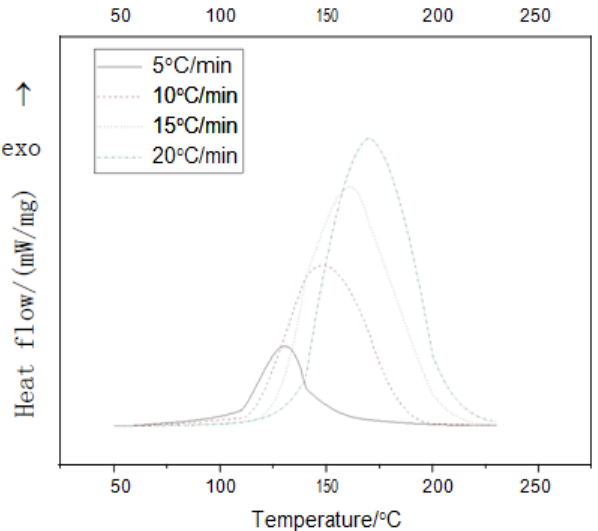
Figure 4. DSC curves of epoxy resin curing system at different heating rates.